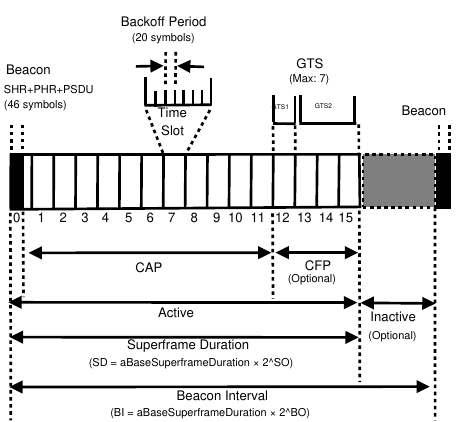
Figure 1. IEEE 802.15.4-2011 time division according to a superframe structure used in beacon- enabled